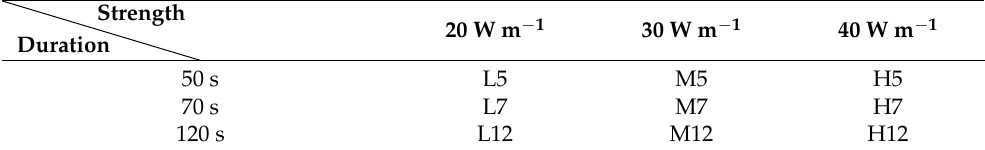
Table 2. The strength and the duration of different heating